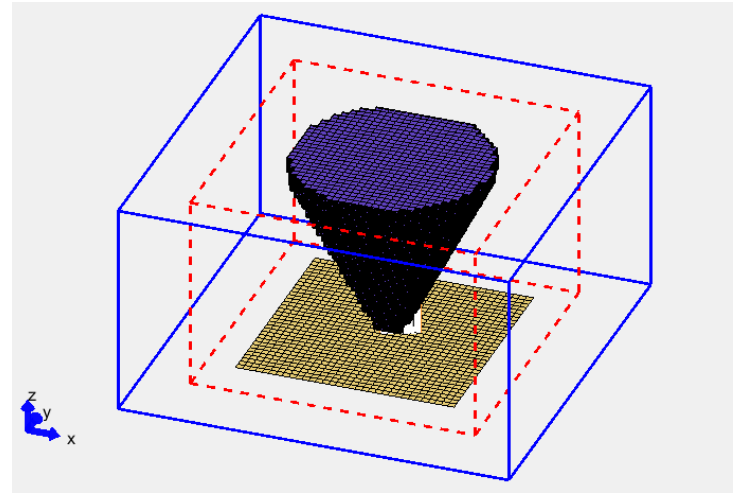
Figure 3: The proposed DRA calculated by FDTD method.